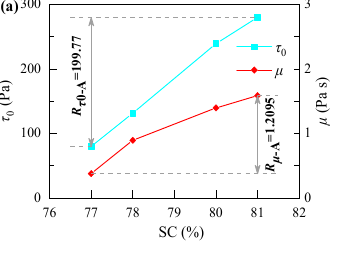
Figure 5. Relation curves of rheological properties with ( a ) SC (solid concentration), ( b ) CAsD (coarse aggregates dosage), and ( c ) CD (cement dosage) by range analysis.